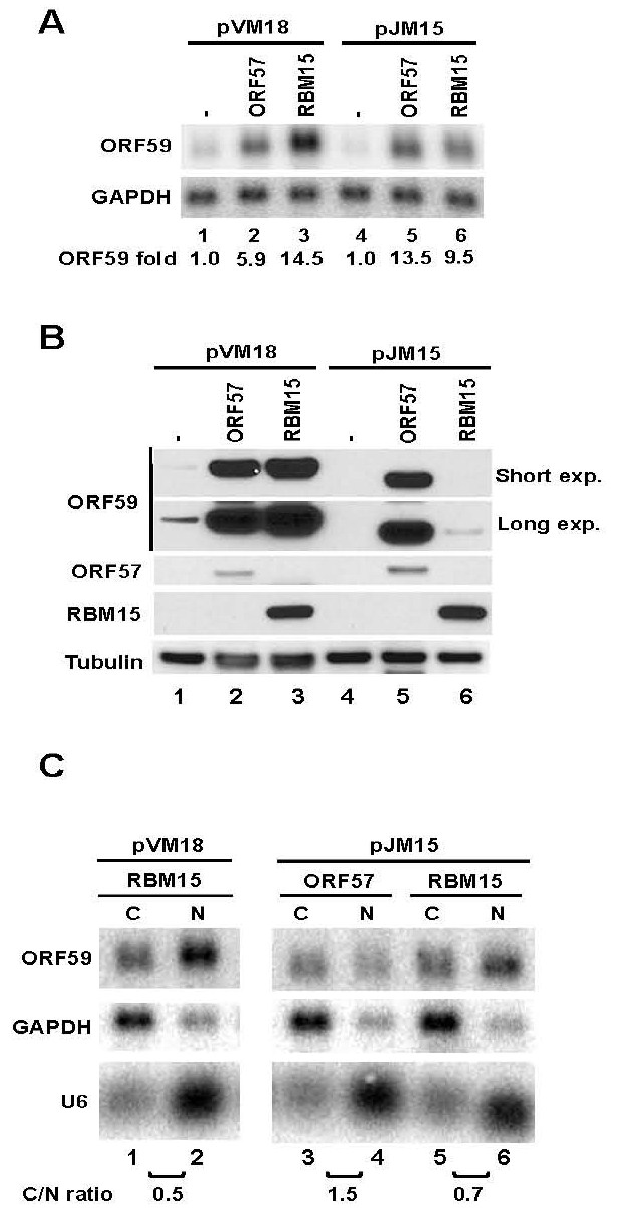
Figure 4. ORF57 but not RBM15 promotes protein translation from an ORF59 MRE-deletion mutant. ( A ) and ( B ) Total RNA from HEK293 cells transfected with each of the ORF59 constructs in the absence or presence of ORF57, or RBM15 was examined by Northern blot ( A ) as described in Figure 1B for the expression of ORF59 and GAPDH. Protein samples from the same set of HEK293 cells were examined by Western blot ( B ) using an anti-FLAG antibody to detect the expression of both ORF59 and ORF57 or an anti- β-tubulin antibody for sample loading. Two exposures (exp.), short and long, are shown for anti-FLAG ORF59 blot. ( C ) Fractionated cytoplasmic (C) or nuclear (N) RNA from HEK293 cells transfected with wt ORF59 (pVM18) or its MRE-deletion mutant (pJM15) in the presence of ectopic expression of RBM15 or ORF57 was examined by Northern blot as described in Figure 3C for ORF59 RNA expression and calculated as a C/N ratio for its cytoplasmic versus nuclear RNA levels. Both GAPDH and U6 RNAs were blotted for fractionation